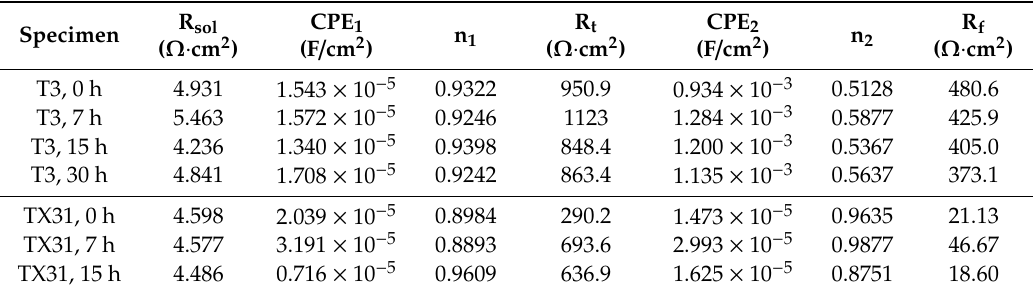
Table 1. Fitting parameters obtained from EIS spectra of aged Mg-3Sn and Mg-3Sn-1Ca alloys in 3.5 wt.% NaCl solution.